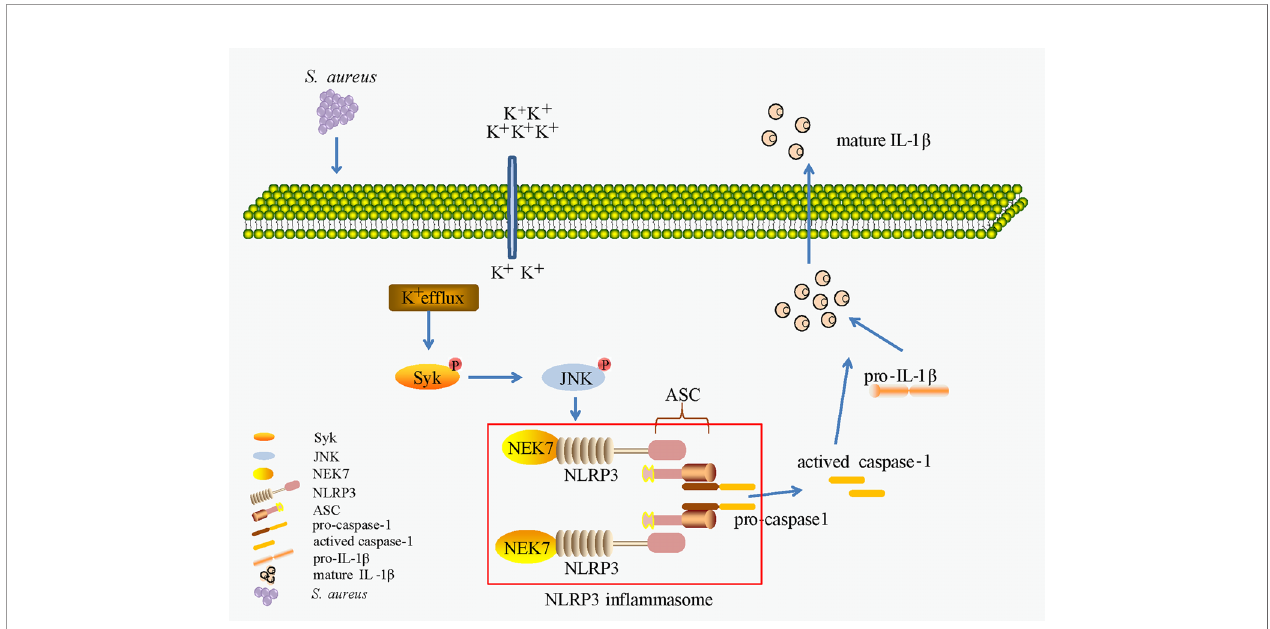
FIGURE 10 | K + ef fl ux/Syk/JNK was important in NEK7-NLRP3 interaction and NLRP3 in fl ammasome activtion upon S. aureus